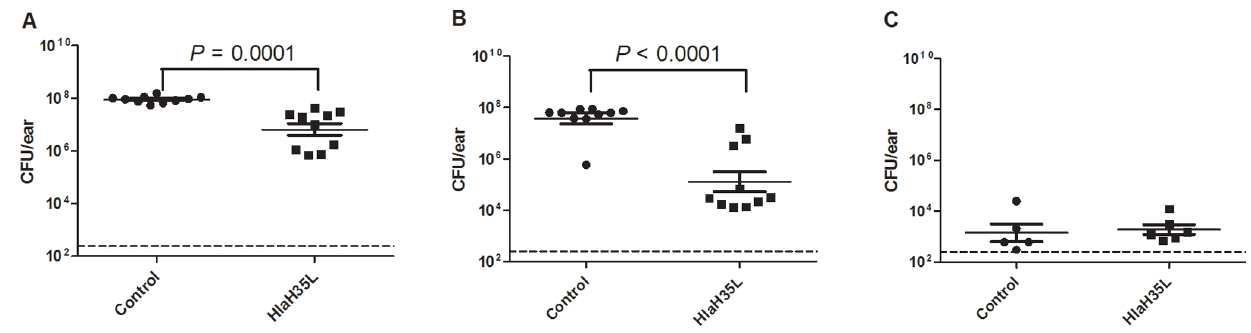
N Figure 2. Analysis of HlaH35L in a skin and soft tissue infection model of S.aureus infection. Control animals receiving aluminum ) and animals receiving HlaH35L with adjuvant ( & ) were compared at days four (A), seven (B), and fourteen (C) post- hydroxide/CpG adjuvant ( challenge. The CFU per ear are plotted, with the mean + / 2 SEM indicated for each group and P value calculated by two-tailed Student’s t test. The dashed line indicates the limit of detection.